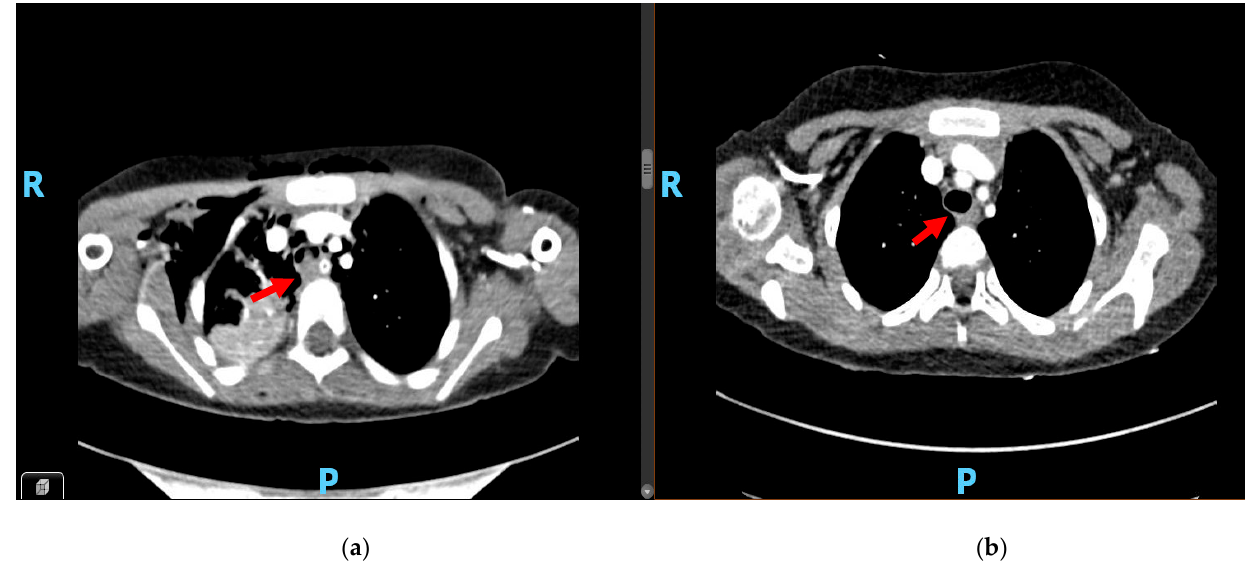
Figure 1. ( a ): CT scan at the diagnosis, showing the endotracheal lesion (red arrow). ( b ): CT scan shows the complete response achieving after eight months of therapy.